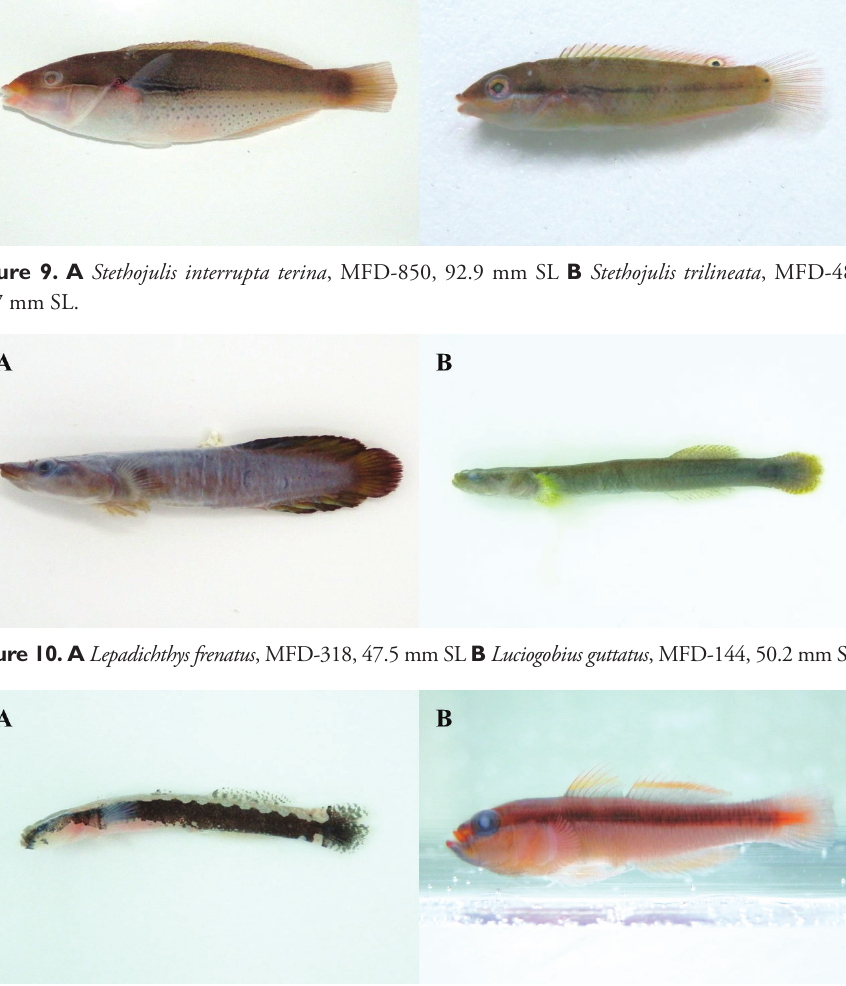
Figure 11. A Clariger cosmurus , MFD-682, 29.8 mm SL B Trimma grammistes , MFD-495, 20.7 mm